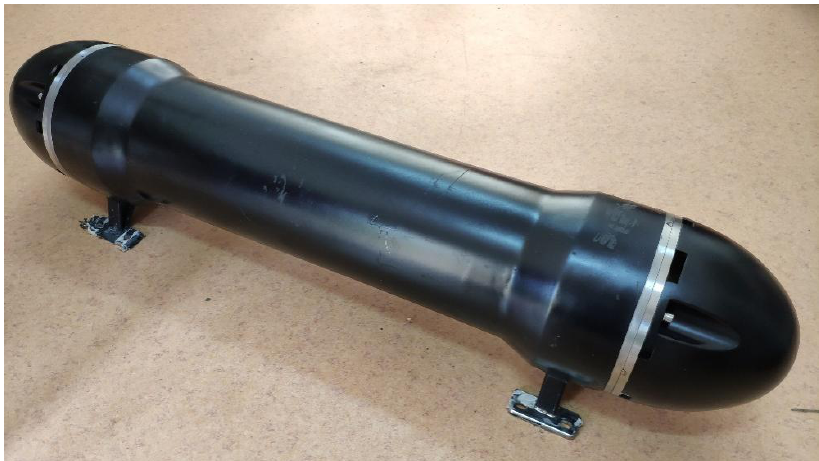
Figure 8. Physical photo of magnetic antenna damping